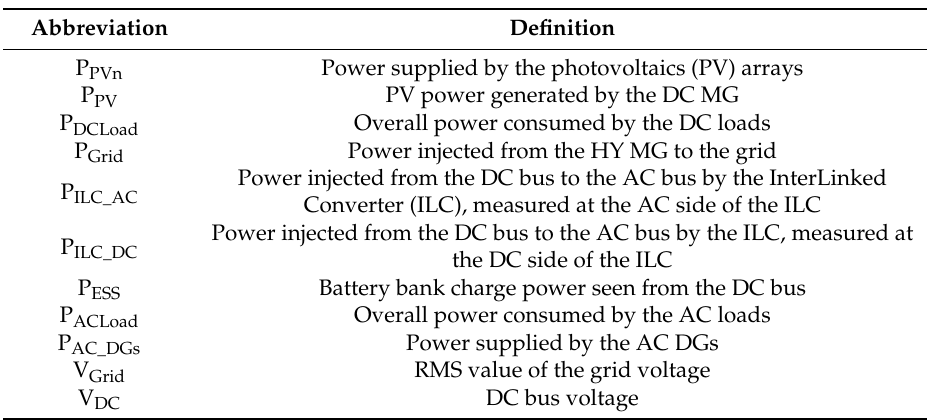
Figure 11. Conceptual scheme of the experimental hybrid microgrid with eight nodes.